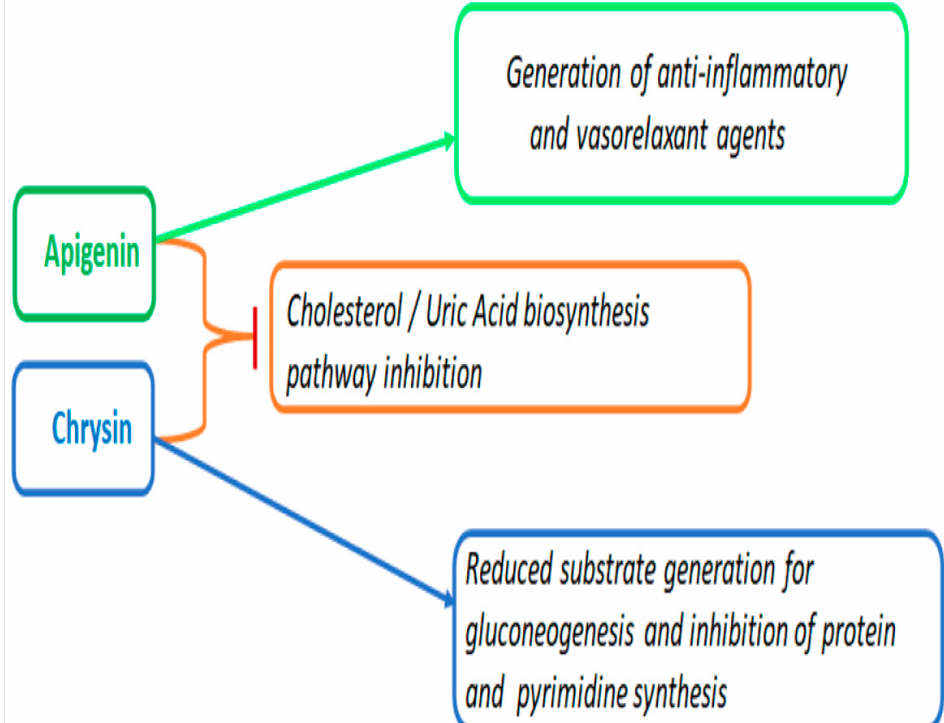
Figure 11. Summary diagram demonstrating the distinct and similar metabolic pathways regulated by apigenin and chrysin. Apigenin, through the regulation of the alpha-linolenic and linoleic acid pathways, generates endogenous anti-inflammatory and vasorelaxant metabolites. On the other hand, chrysin, by regulating alanine and urea cycles, suppresses the gluconeogenesis, protein synthesis, and pyrimidine synthesis pathways. Both apigenin and chrysin demonstrate converging effects by inhibiting the generation of metabolites involved in biosynthesis of cholesterol and uric acid